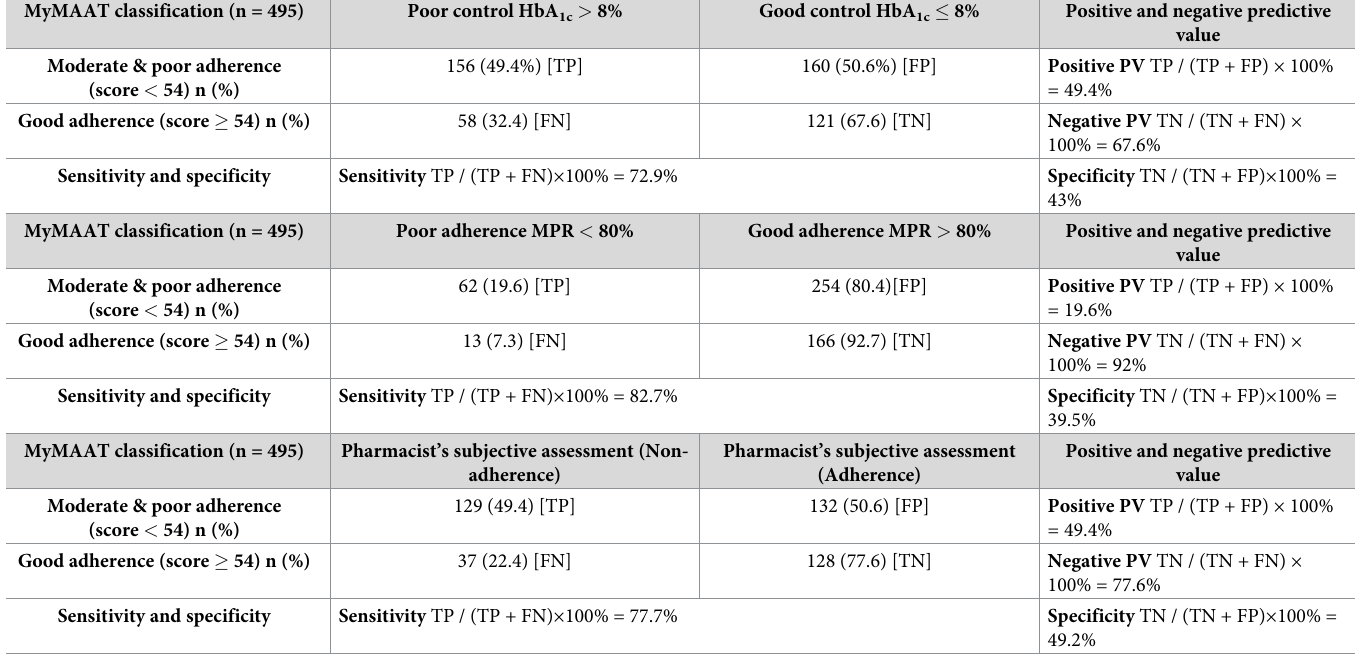
Table 7. Sensitivity and specificity test for